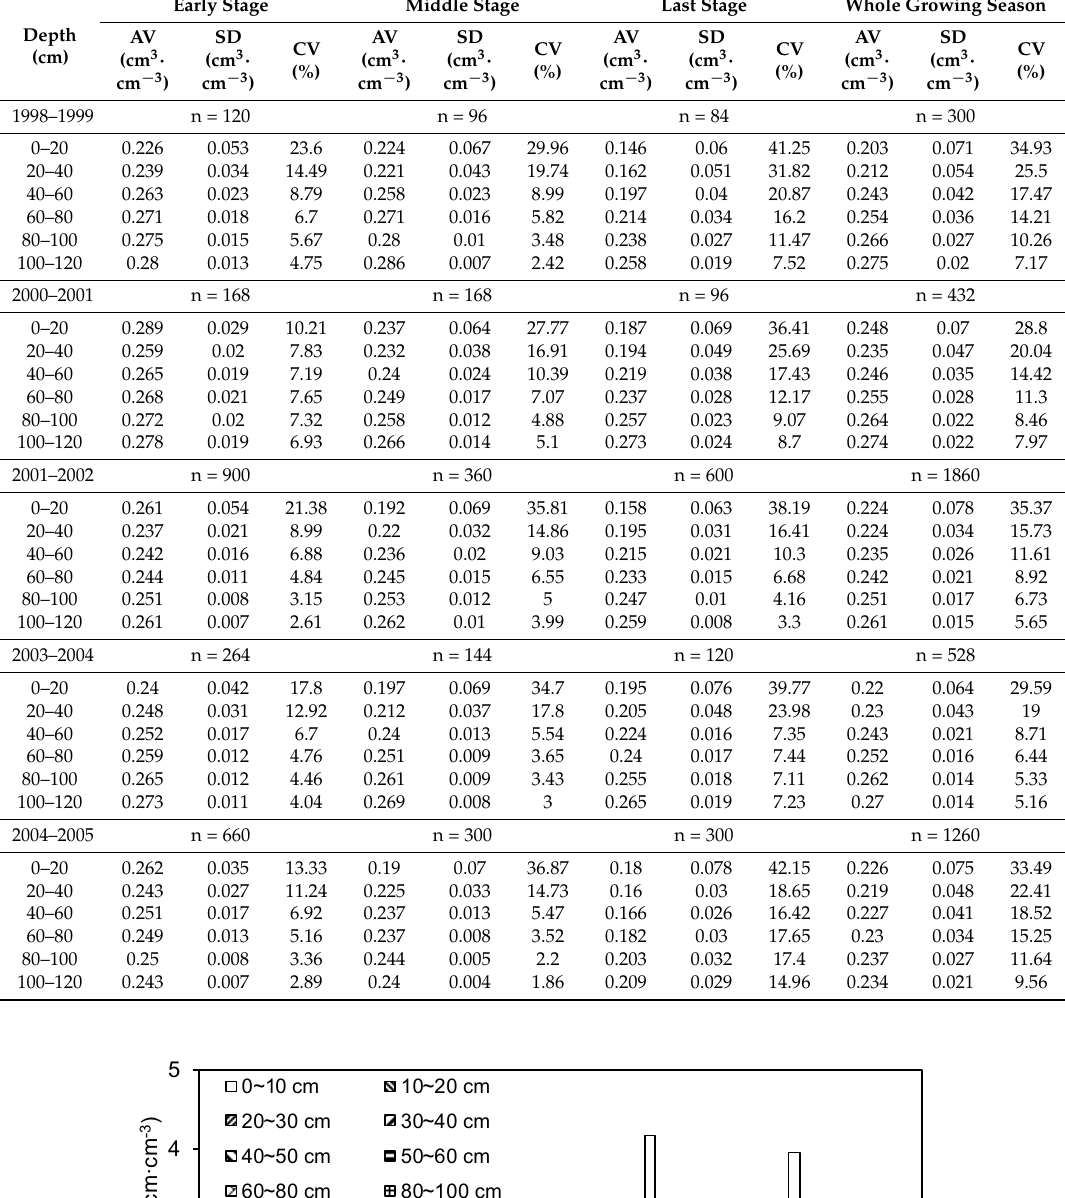
Table 1. Average value (AV), standard deviation (SD), and coefficient of variation (CV) of soil water content at different layers in the soil profile during different growing stages of winter wheat.